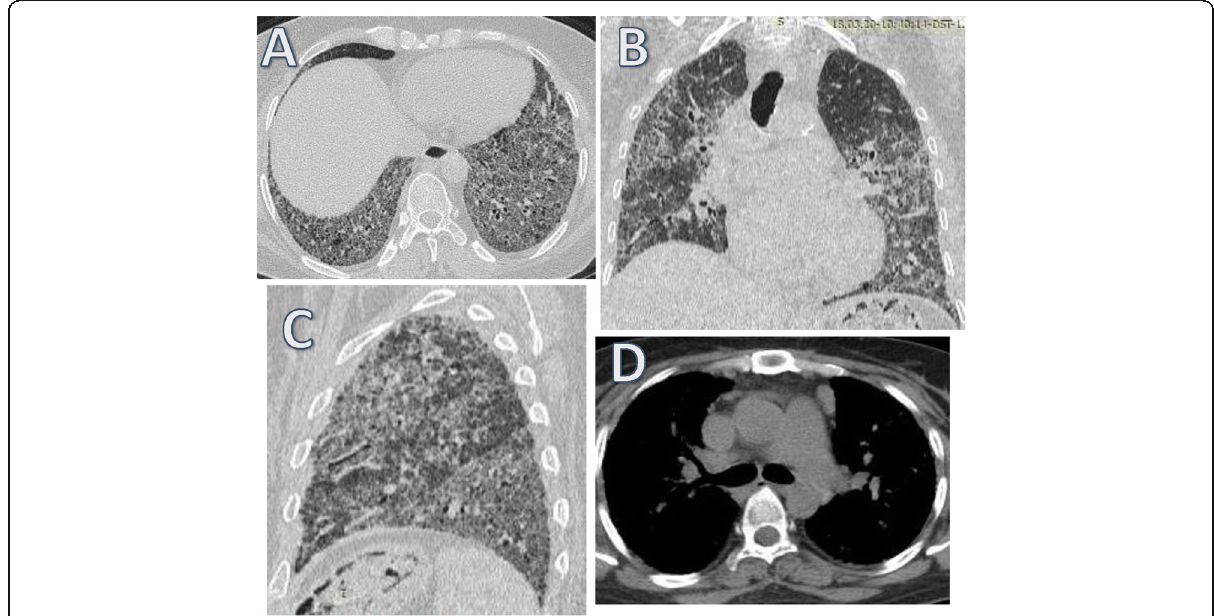
Fig. 1 A 43-year-old female patient presenting with progressive dyspnea. a – c Axial, coronal, and sagittal reformatted images of HRCT chest (lung window) showing interstitial lung disease in the form of bilateral fairly symmetrical predominantly subpleural ground glass opacification, thickening of interlobular and intralobular septae with traction bronchiectasis and bronchiolectasis and bilateral lower lobar reduced volume. Patulous esophagus is also noted on axial and coronal HRCT scans. d Axial mediastinal window showing prominent main pulmonary artery (about 3 cm) and enlarged prevascular lymph